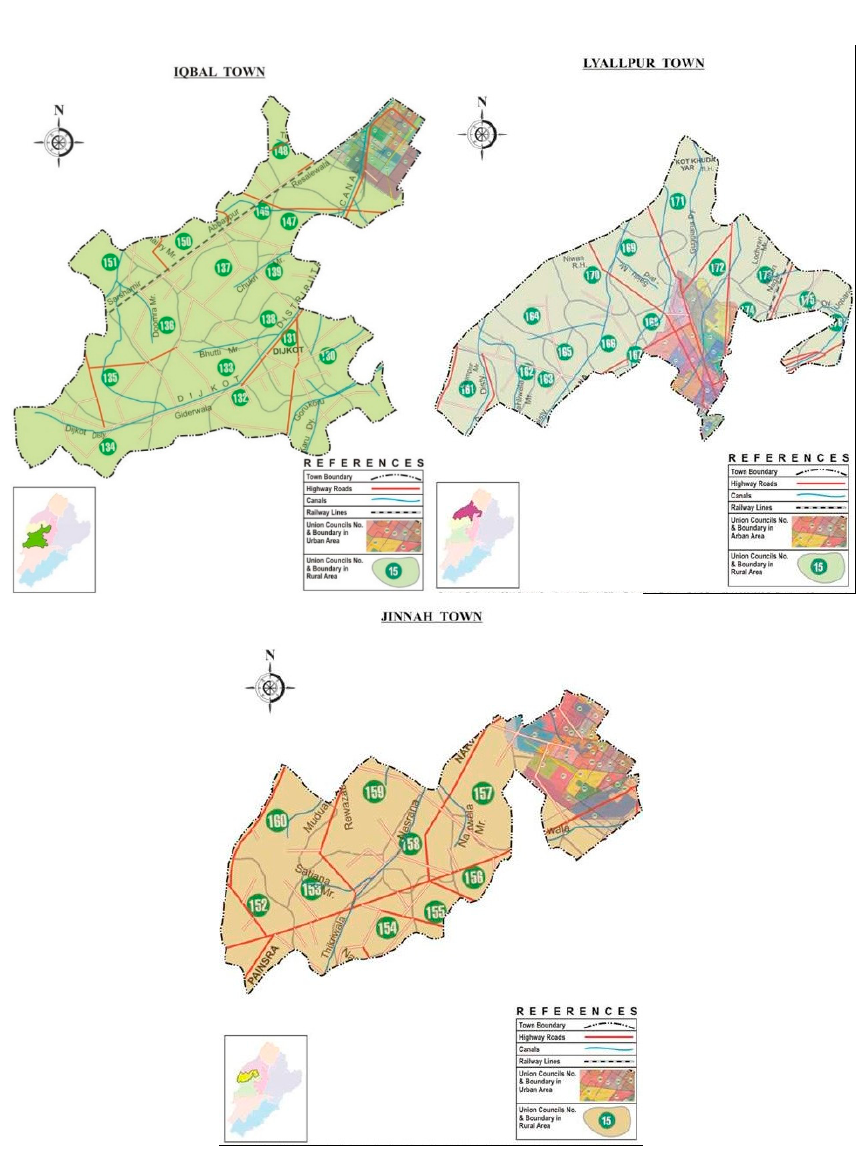
Figure A1. Maps for four major towns of Faisalabad.